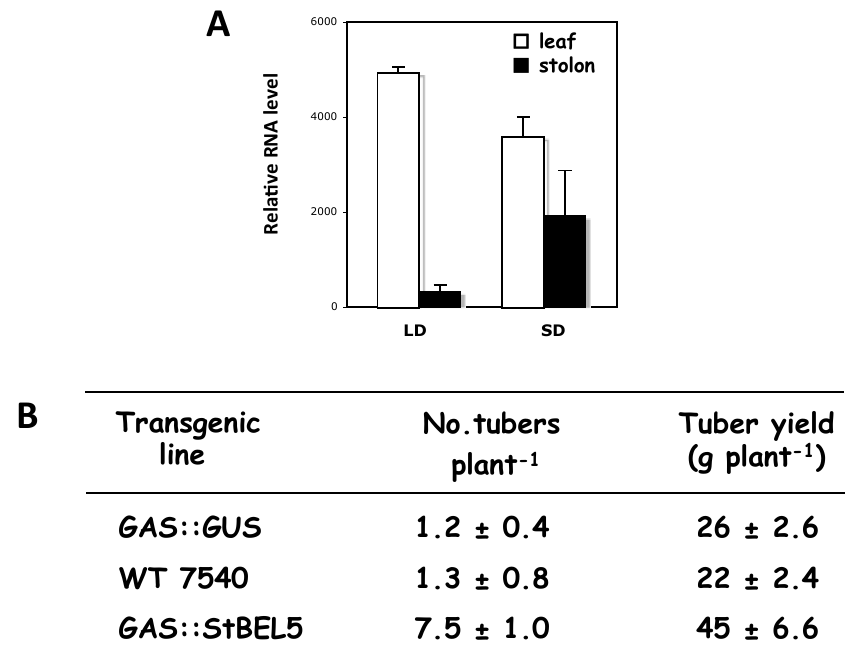
Figure 3. The correlation of StBEL5 RNA movement into stolon tips ( A ) and tuber yields ( B ) in a transgenic line expressing full-length StBEL5 transcripts driven by the leaf-specific CmGAS promoter [46,49]. A transgenic line with GUS transcripts driven by the same leaf-specific promoter was included as a control ( B ). Transgenic plants ( S. tuberosum ssp. andigena ) were grown under greenhouse conditions until the 12–14 leaf stage and then grown under short or long days for 10 days before harvest. Harvested plants were scored for tuber numbers after 10 days and tuber yields after 28 days under SD conditions ( B ). Total RNA was extracted from 0.5-cm stolon tips and new leaves from three separate plants. RT-PCR was performed using a non-plant sequence tag fused to all transgenic RNAs, and a gene-specific primer from the 3 ′ UTR of St- BEL5 ( A ). The full-length BEL5 and GUS constructs were cloned downstream from the CmGAS promoter in the binary vector, pBI101.2. Non-transformed control plants are designated “WT 7540”. Homogenous PCR products were quantified ( A ) by using ImageJ software and normalized by using rRNA values [9]. Standard errors of the means of the three biological replicates are shown ( A , B ). □ , leaf; ■ , stolon ( A ). GUS expression was detected in leaves, but not stolons of GAS::GUS transgenic lines of S. tuberosum ssp. andigena [46]. With permission of the authors [9].